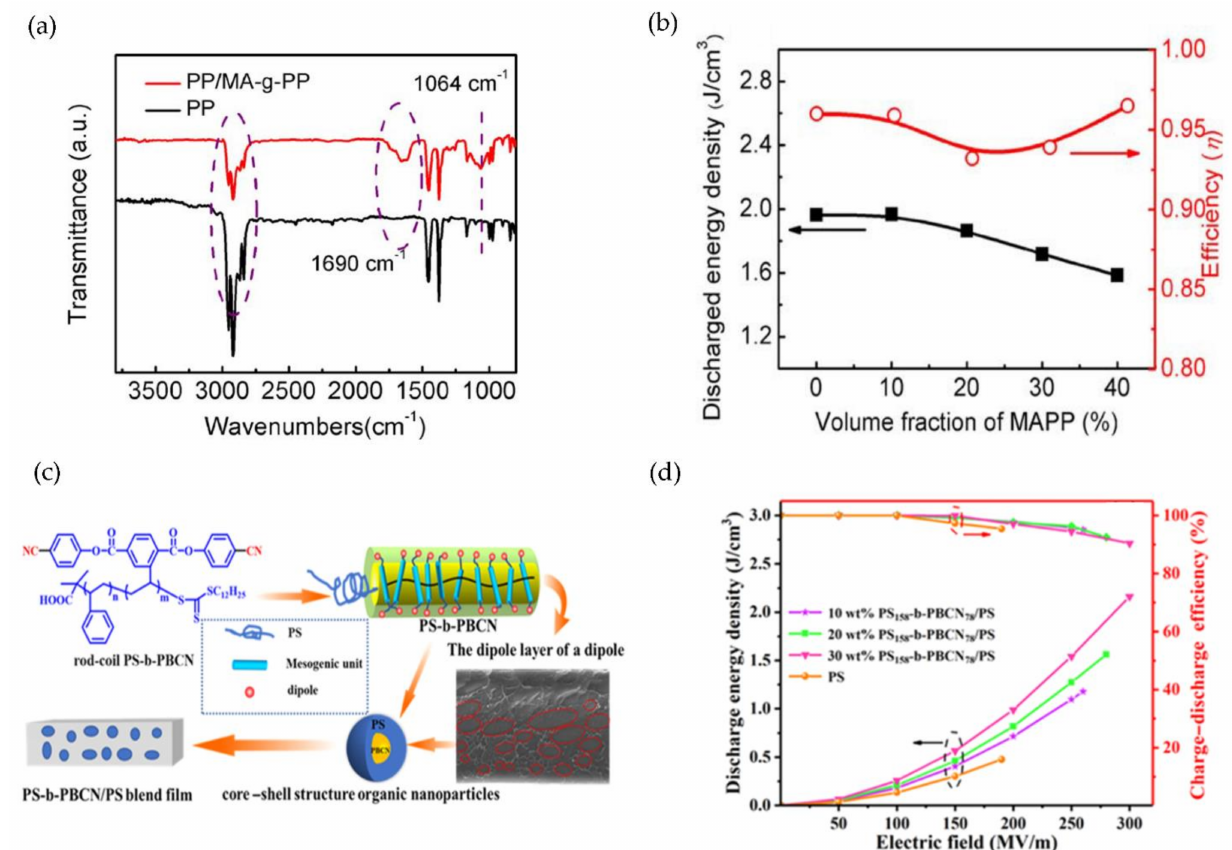
Figure 5. ( a ) Comparison in FTIR spectra between pure PP and 40 vol % MA-g-PP/ PP hybrid films; ( b ) The relationship between the discharge energy densities and efficiencies of PP/MA-g-PP hybrid films with various MA-g-PP volume fractions; reprinted with permission from [75]. Copyright (2017), Wiley. ( c ) Schematic illustration of the mechanism of PS-b-PBCN organic fillers in the PS matrix; ( d ) Energy storage properties of PS158-b-PBCN78/PS blends. Reprinted with permission from [78]. Copyright (2021), American Chemical